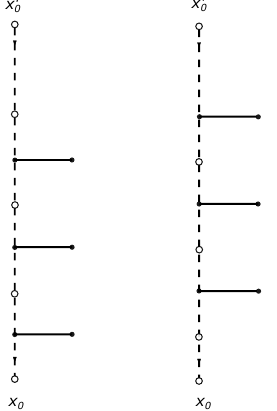
Figure 4 . Graphic representation of the integral kernel of fermionic graph-building operators appearing in the general Feynman integral of figure 3. These two operators commute with each other as explained in section 5 and with the scalar transfer matrix depicted in figure 2. In particular, their expansion over the basis of eigenfunctions of the model (1.10) has a relatively simple form worked out in section